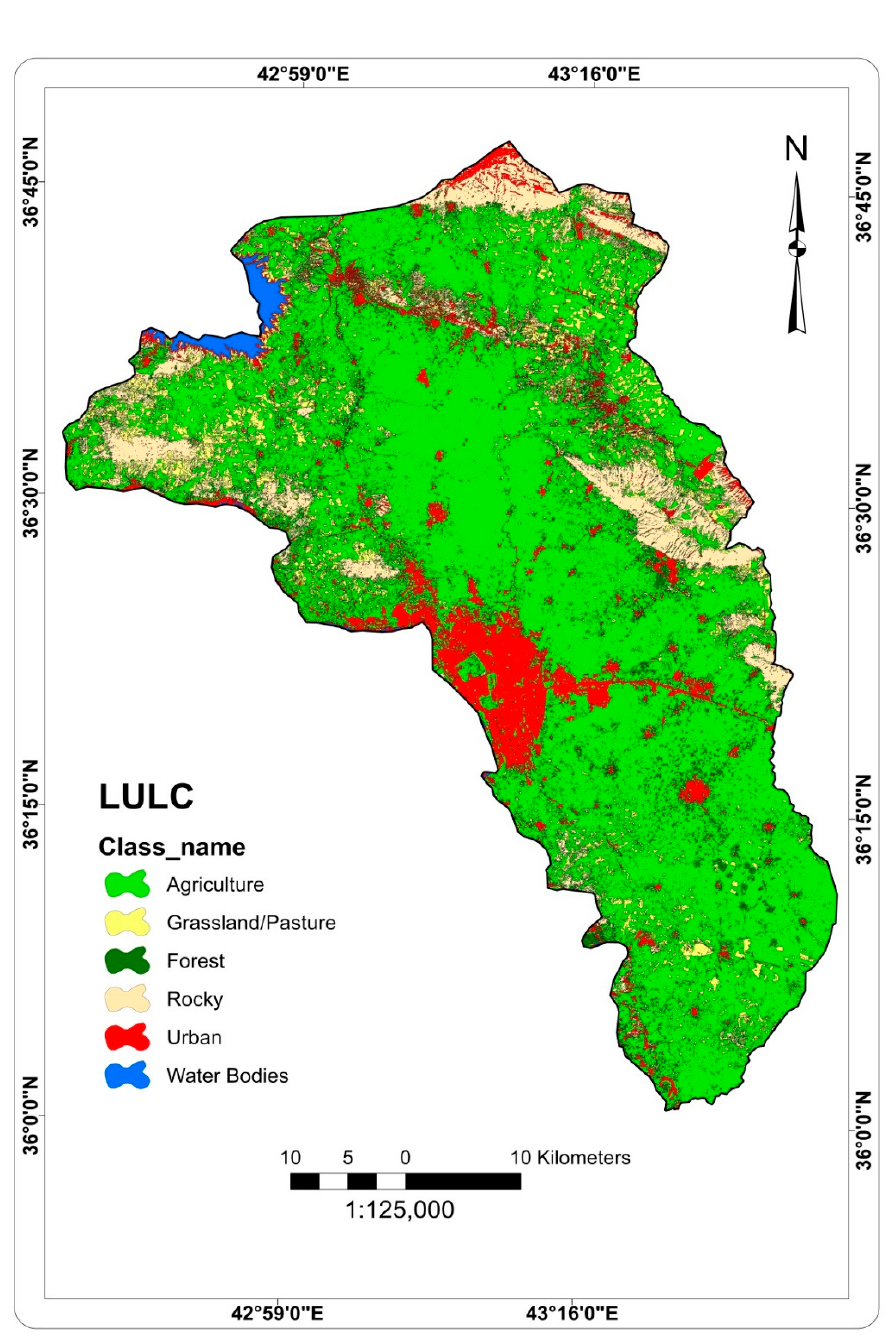
Figure 3. Major LULC in the study area.